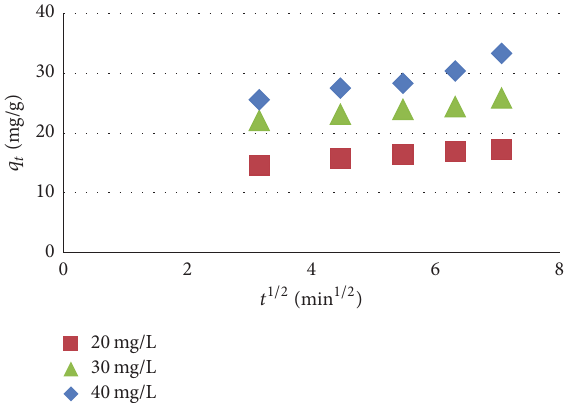
Figure 16: Intraparticle diffusion plot for adsorption of AY on DNPH- 𝛾 -alumina nanoparticles at different initial concentrations. Table 4: Energy of activation for the adsorption of AY and MB on